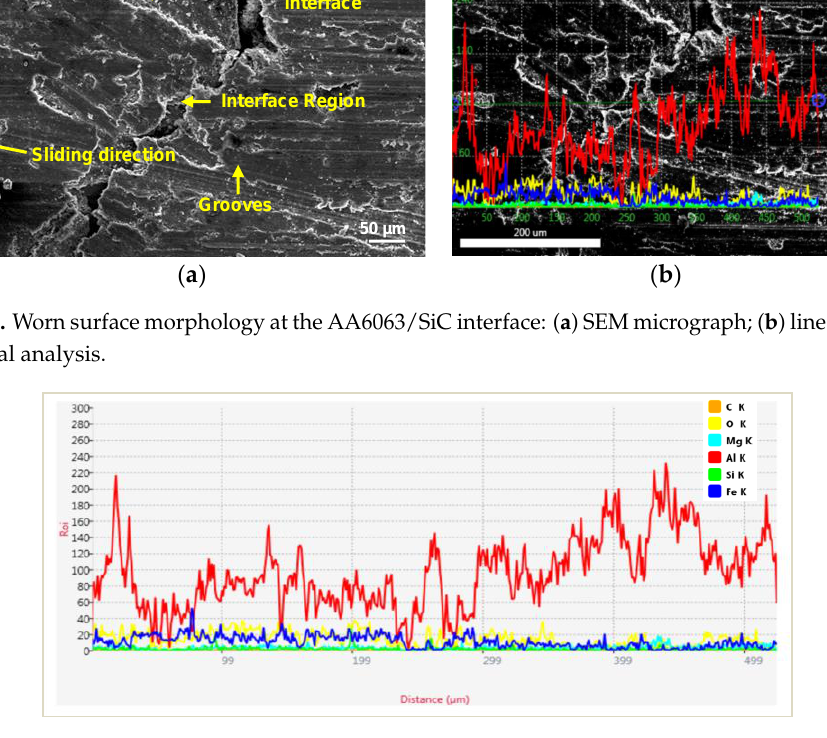
Figure 10. EDAX analysis of the interface.